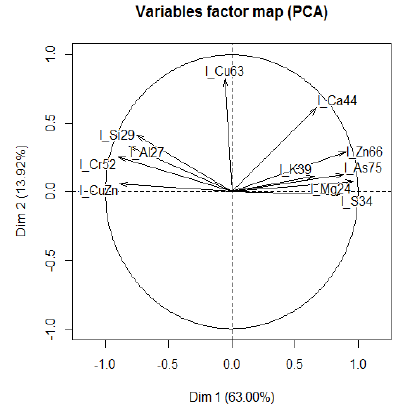
Figure 4. Principal Component (PCA) analysis on metal and microelements that were significantly changed.